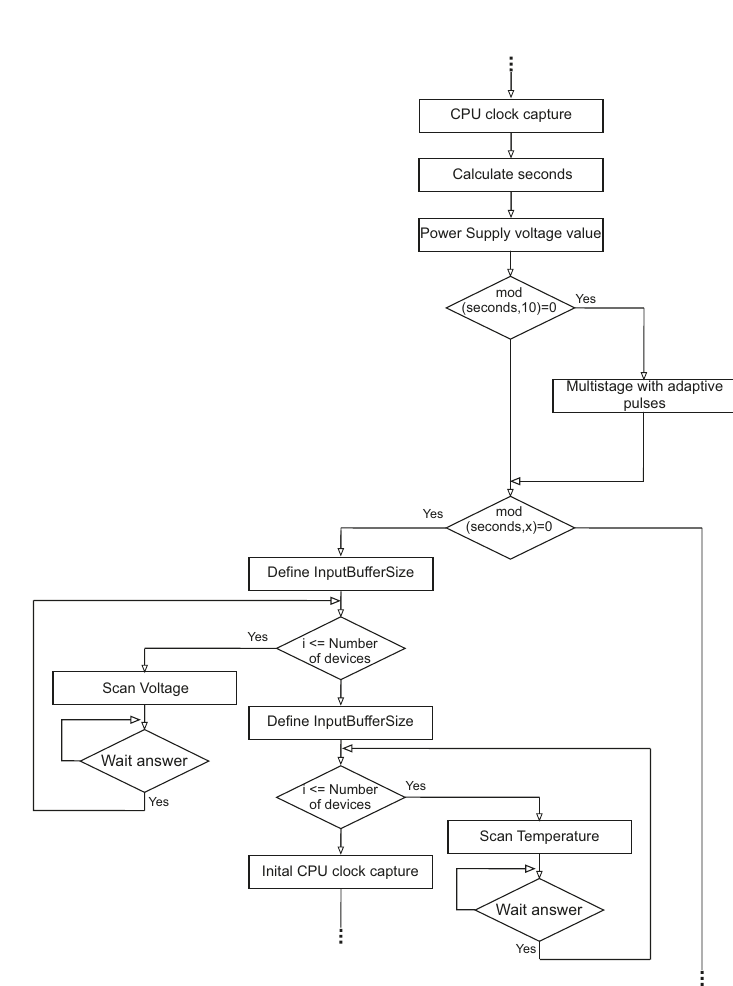
Figure 12. Flowchart of the program implemented in the main control unit—Second Segment.